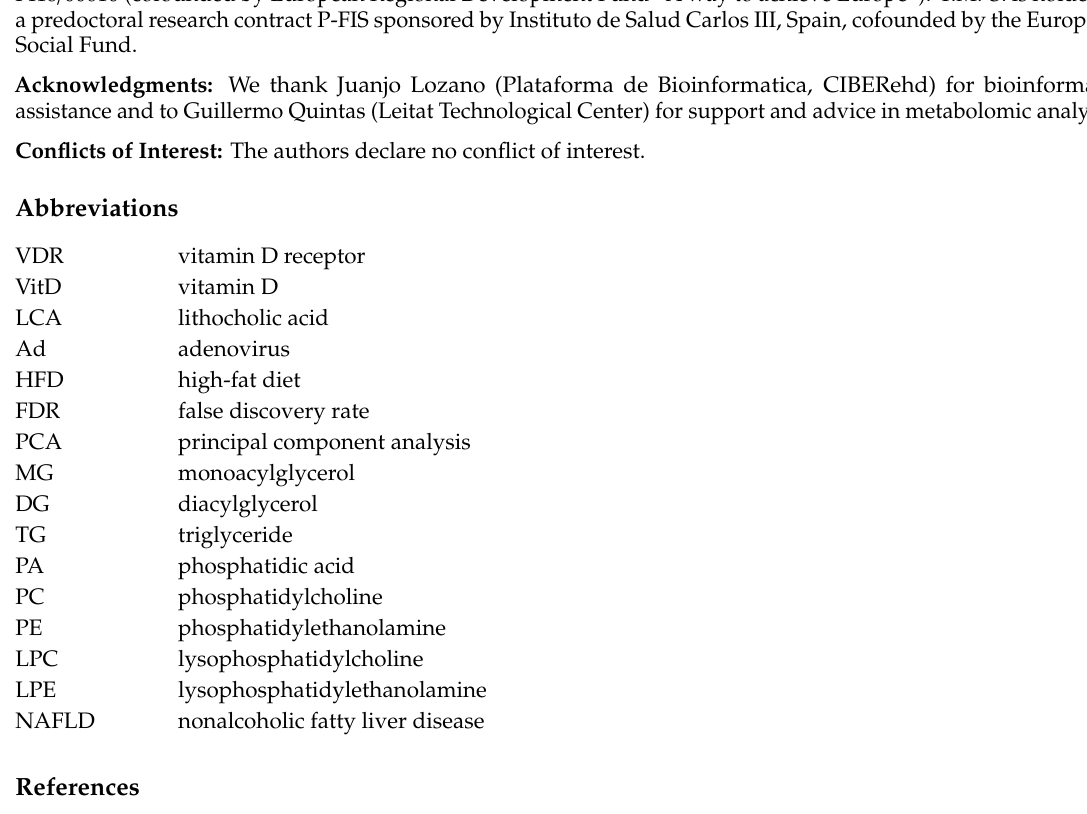
Figure S1: Response of CYP24A1 to VDR activation in human hepatic cells; Figure S2: Response of novel VDR-target genes to LCA; Figure S3: PCA score plots of Ad-VDR human hepatocytes after incubation with VitD or vehicle for 8 or 24 h; Figure S4: Relative intracellular levs of PCs and PEs in cultured human hepatocytes exposed to VitD; Figure S5: Relative intracellular levs of betaine and phosphatidic acids (PAs) in cultured